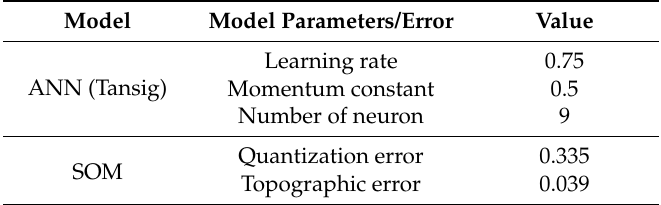
Table 2. ANN optimized parameters and SOM related